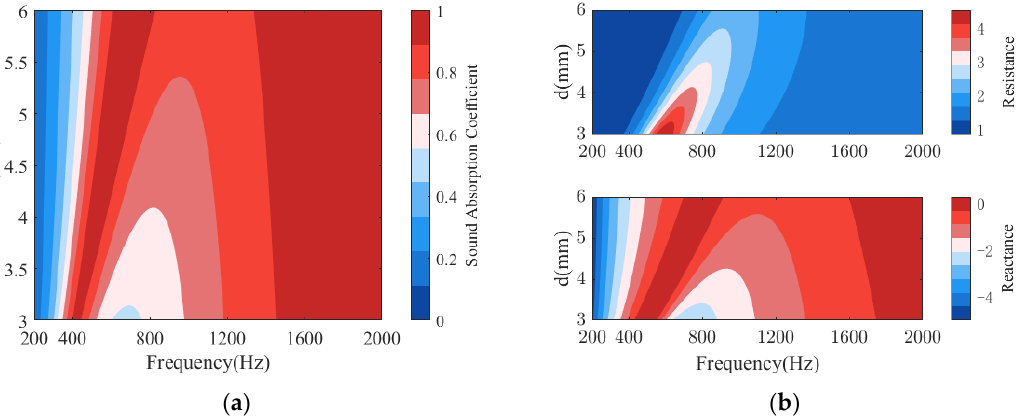
Figure 8. Effects of the hole diameter d on the sound absorption of PPCS: ( a ) sound absorption coefficients; ( b ) normalized surface acoustic impedance.